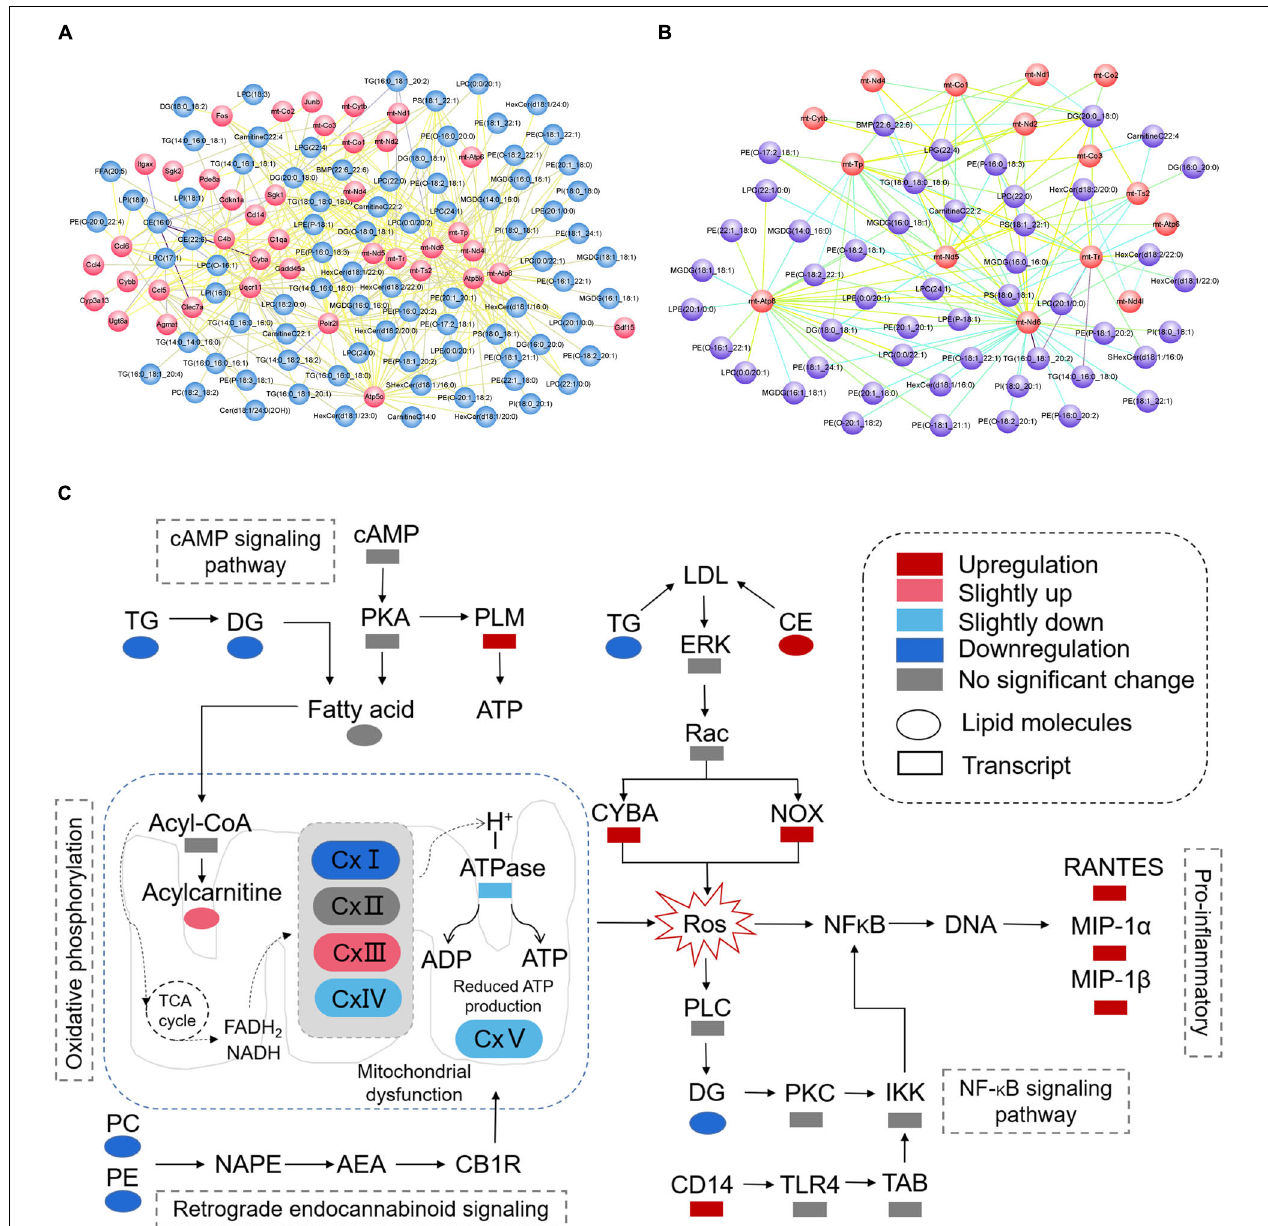
FIGURE 11 | (A) Plot of oxidative stress correlation network. (B) Plot of mitochondrial function-related correlation network. (C) Pathway representation of mitochondrial dysfunction, oxidative stress, and neuroinflammation-related signaling